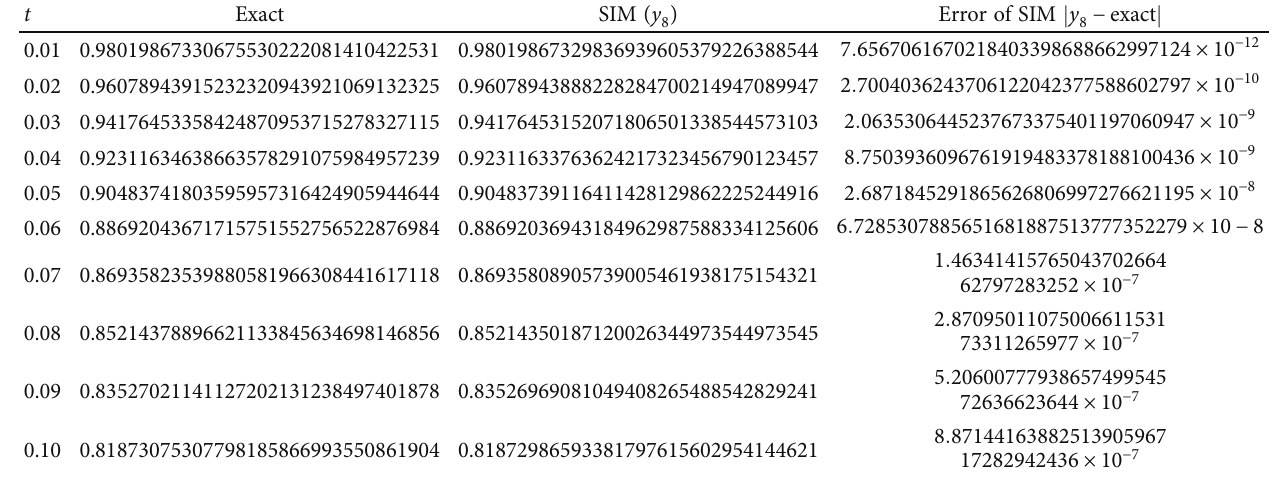
Table 4: Eight-term approximate solution by SIM and comparison with the exact solution of Example 2 for di ff erent values of time variable t and the absolute error E = j y 8 − exact j